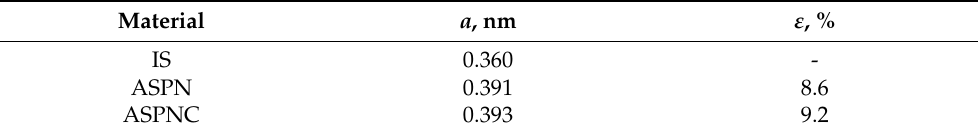
Table 1. Lattice parameter a and lattice distortion ε in the surface layer of AISI 316L steel in its initial state (IS) and after ASPN and